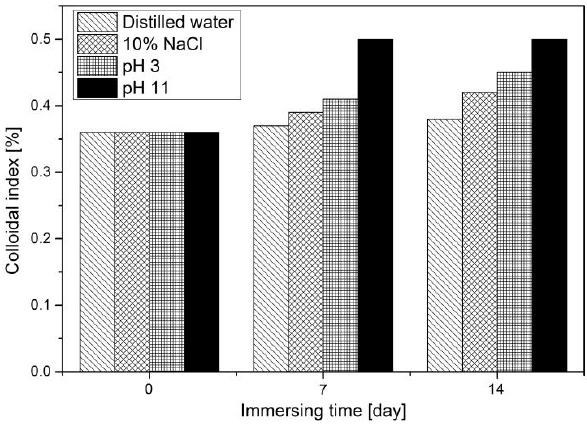
Figure 5. Gaestel index of the 70 # asphalt before and after water solute immersion.